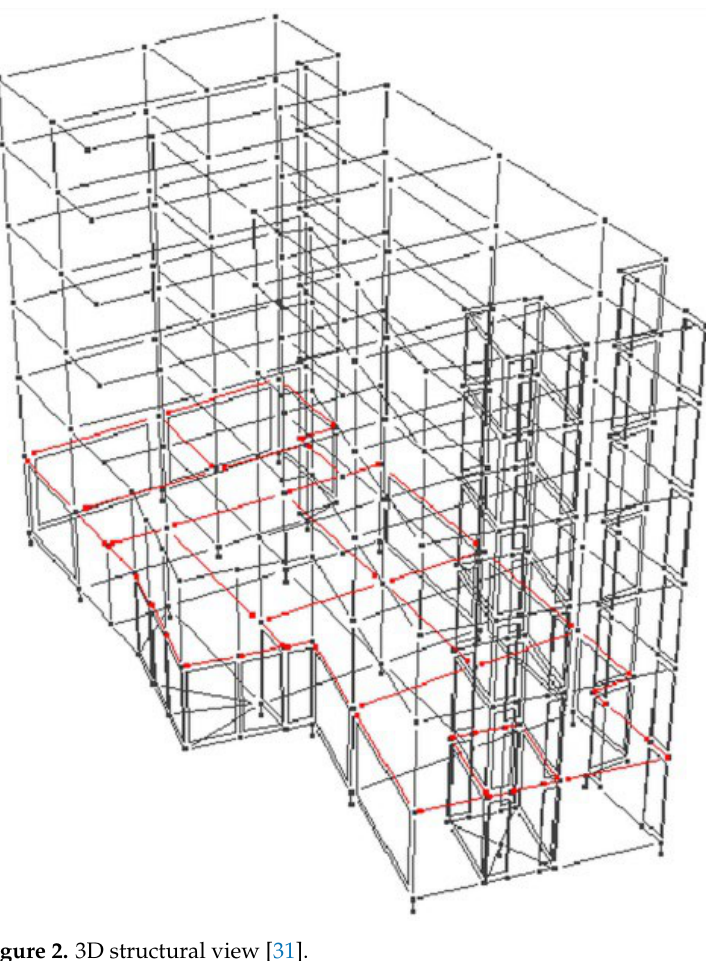
Figure 2. 3D structural view [31]. The computed base shear, lateral displacement and horizontal accelerations were com- pared for both design approaches. Double curved sliding isolators produced a structural design optimization by isolator dimensions reduction. Isolators were designed for a chosen isolation period (4.4 s) in order to obtain a minimum response spectrum ordinate. Accord- ing to [16] the design earthquake for the Ultimate Limit State has a 225 year return period (20% probability of exceedance in 50 years). The spectrum compatible records considered in this study comply to the design spectrum. A 475 years return period (10% probability of exceedance in 50 years) was considered as maximum expected earthquake [32]. Isolators were designed to reach 64.2 cm displacement capacity.